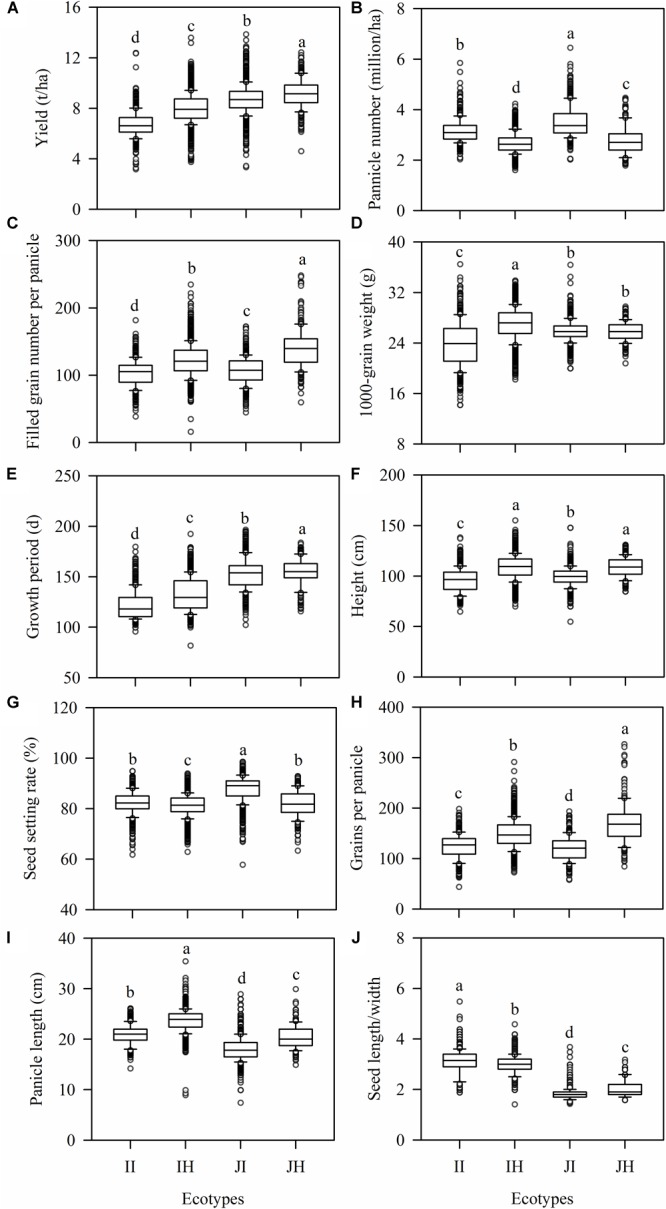
Differences in trait values among rice ecotypes. (A) yield, (B) panicle number per unit area, (C) filled grain number per panicle, (D) 1000-grain-weight, (E) growth period, (F) plant height, (G) panicle length, (H) grains per panicle, (I) seed setting rate, and (J) seed length/width ratio. The four ecotypes are: indica inbred (II) and indica hybrid (IH), japonica inbred (JI), and japonica hybrid (JH). Boxplots represent the median (line), 25–75 quartiles (boxes), 5th and 95th percentile values (error bars) and outliers (dot). Different letters above a column indicate a significant difference (P < 0.05).